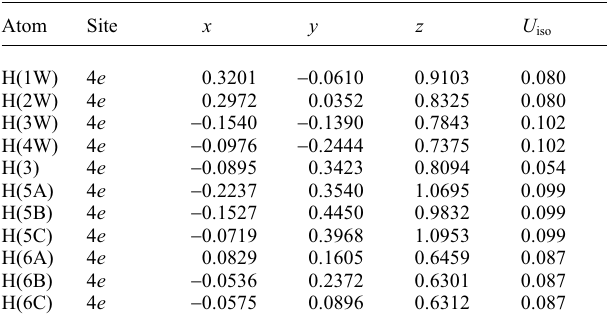
Table 2. Atomic coordinates and displacement parameters (in Å 2 )